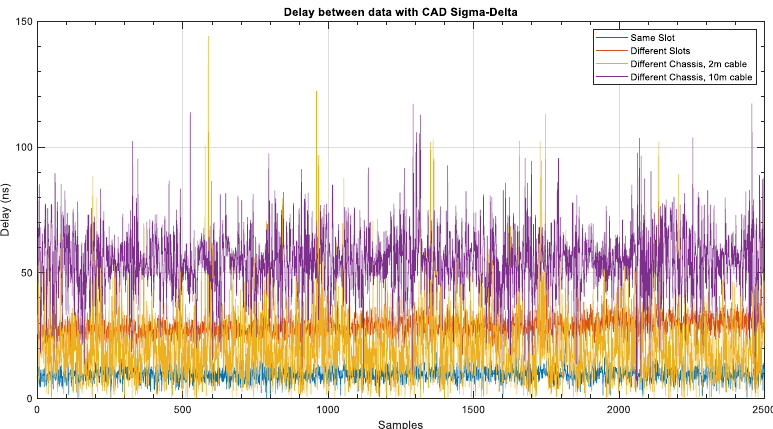
Figure 5. Time series of the four Sigma-Delta converter tests.